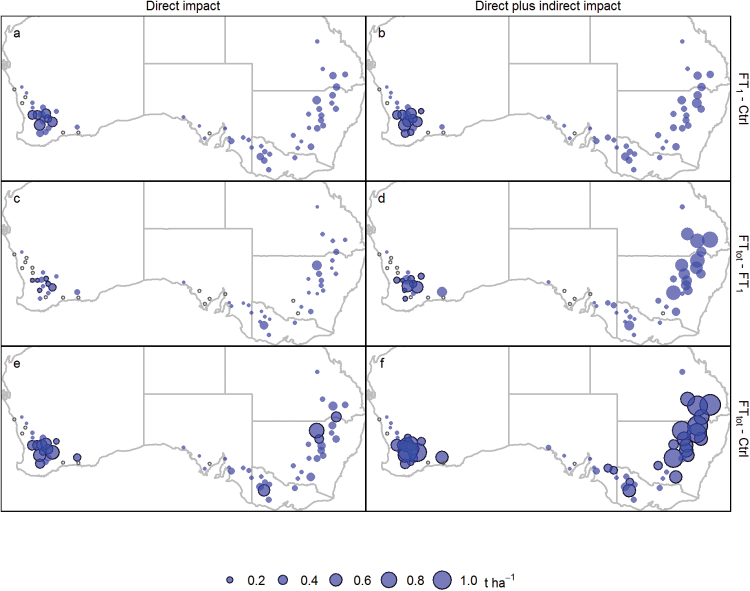
Simulated mean yield advantage of mid-maturing cultivars when (i) increasing the frost tolerance to –1 °C (i.e. FT1–Ctrl; a and b, top maps); (ii) considering the additional yield gain achieved with a total frost tolerance (i.e. FTtot compared with –1 °C tolerance, i.e. FTtot–FT1; c and d, middle); and (iii) looking at the total yield advantage between total tolerance and the current level (FTtot–Ctrl; e and f, bottom). Simulations were done at 60 locations (Fig. 1) for sowing at the optimum sowing date for the current level of tolerance (0 °C, ‘control’; direct impact; a, c, and e, left) or at the optimum sowing date specific to each frost damage threshold level (direct plus indirect impact; b, d, and f, right). The size of the circle corresponds to the average yield increase (t ha–1) for 1957–2013. The open small circles indicate the sites where no yield advantage was simulated and black edges around blue circles indicate that yield advantage was significant (P<0.05).